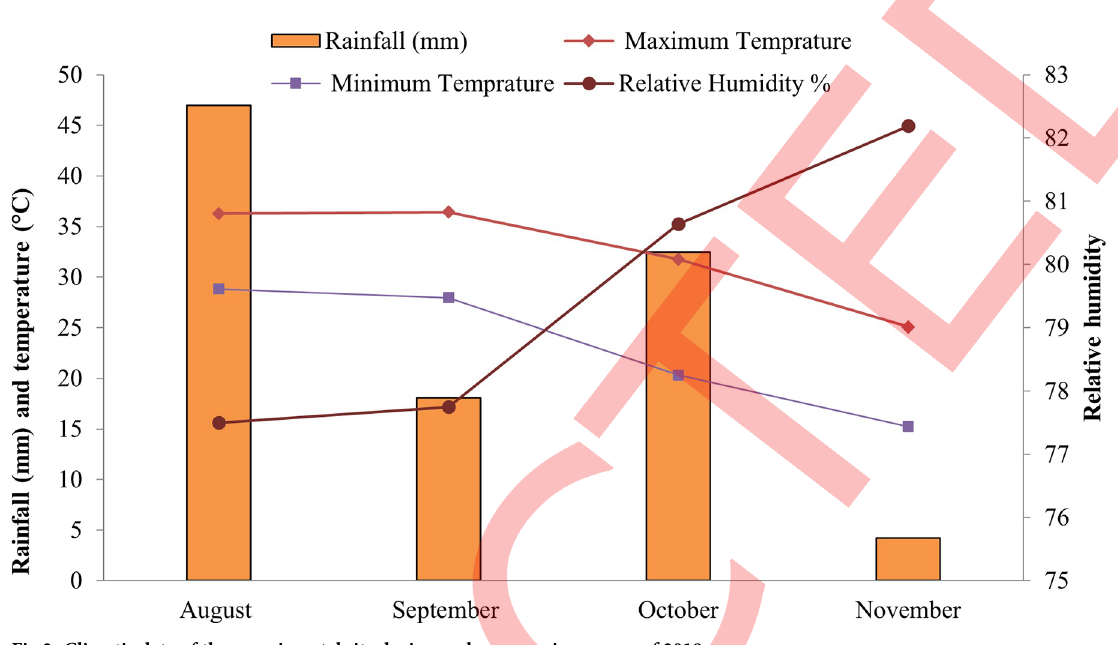
Fig 2. Climatic data of the experimental site during soybean growing season of